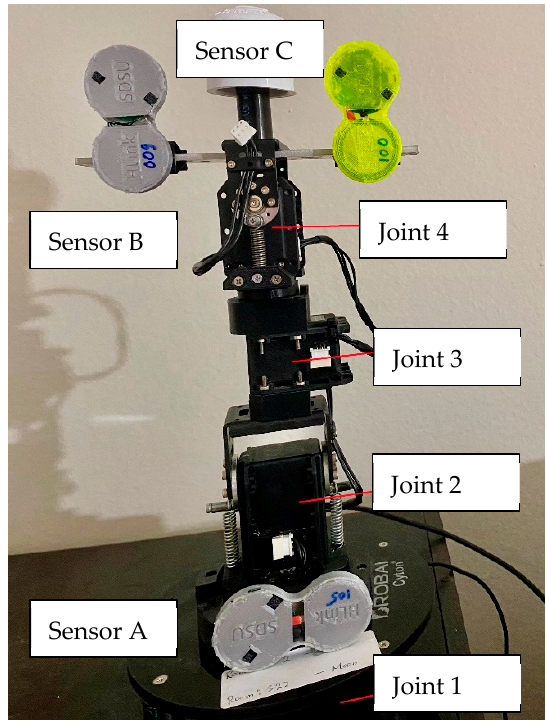
Figure 3. A four-degree-of-freedom (DOF) robotic spine simulator which consists of four links is developed using four servo motors. The wearable sensor cluster communicates wirelessly using Bluetooth low-energy (BLE) technology.